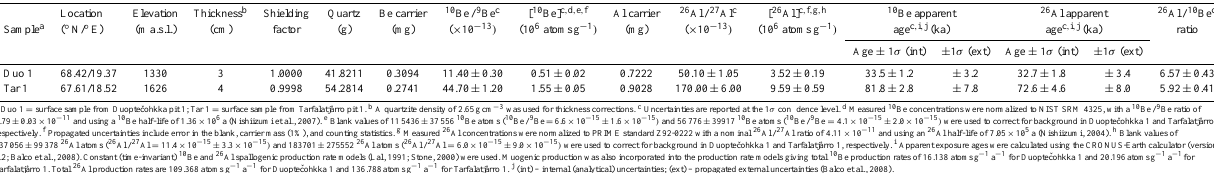
Table 2. Cosmogenic nuclide data, apparent exposure ages, and nuclide ratios.